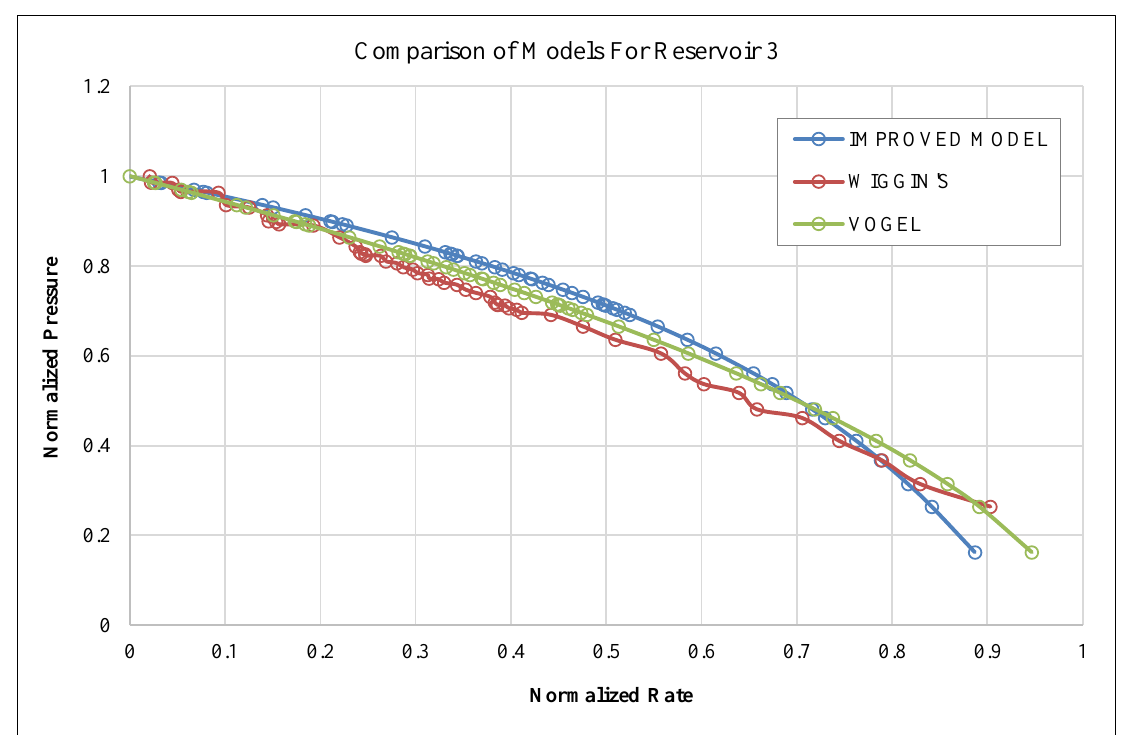
Figure 5. Plot of Normalized Pressure against Normalized Rate for Reservoir